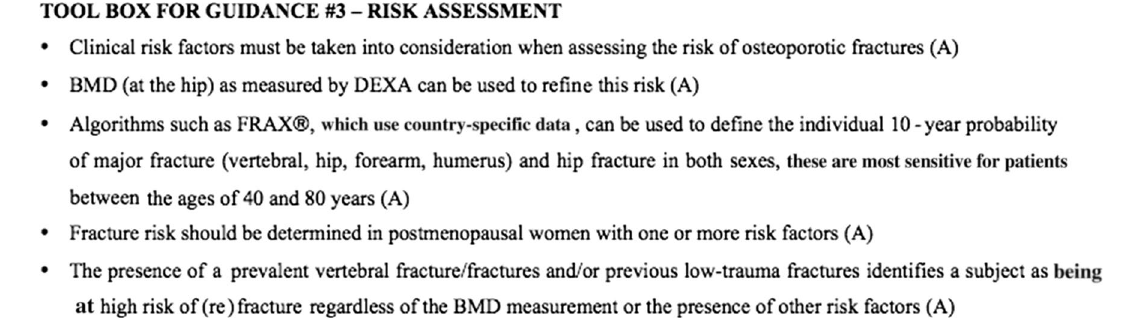
Fig. 3 Toolbox for guidance: osteoporotic fracture risk